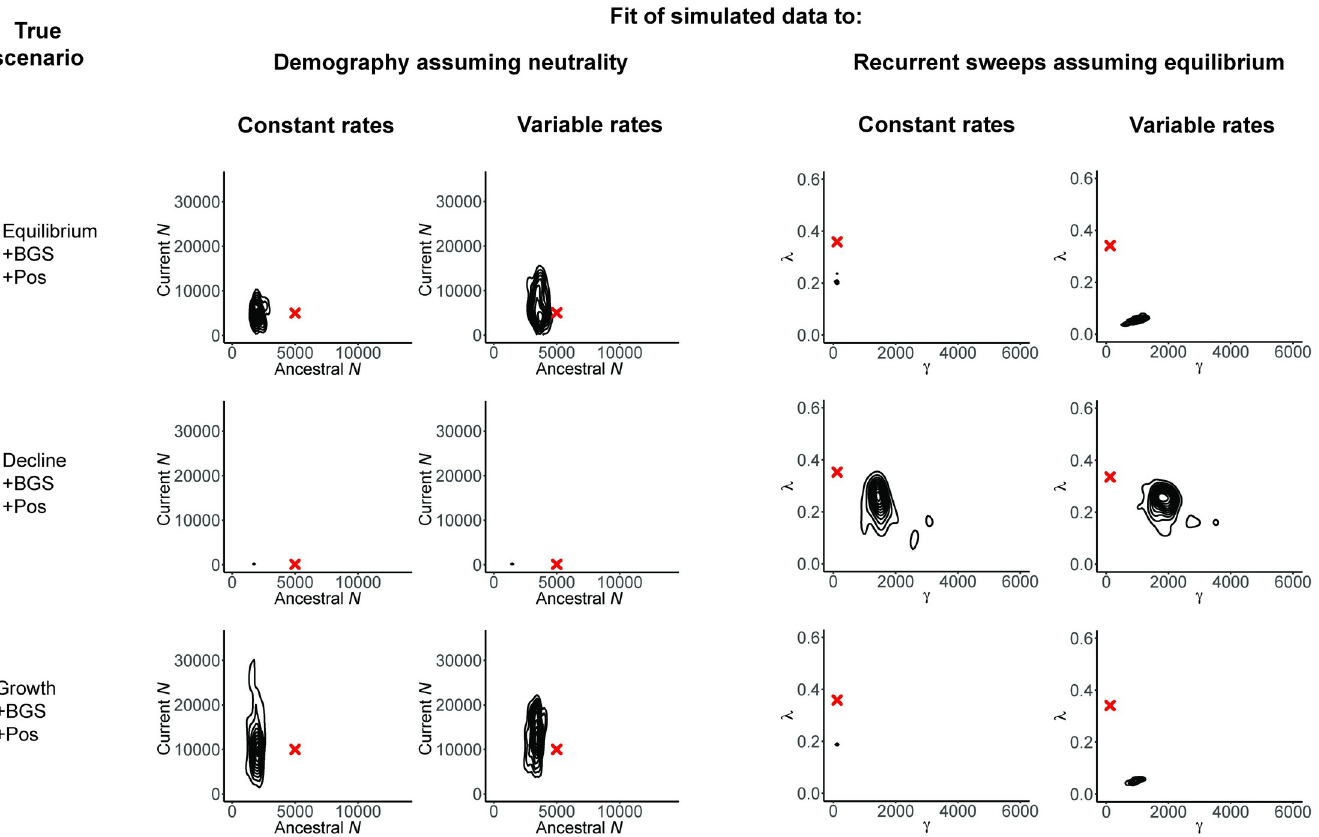
Fig 4. The effects of not correcting for mutation and recombination rate heterogeneity. Three scenarios are here considered: equilibrium population size with background selection and recurrent selective sweeps (“Eqm +BGS + Pos”), declining population size together with background selection and recurrent selective sweeps (“Decline + BGS + Pos”), and growing population size together with background selection and recurrent selective sweeps (“Growth + BGS + Pos”). Inference is again made under an incorrect demographic model assuming neutrality, as well as an incorrect recurrent selective sweep model assuming equilibrium population size. However, within each category, inference is performed under 2 settings: mutation and recombination rates are constant and known and mutation and recombination rates are variable across the region but assumed to be constant (see Methodology). Red crosses indicate the true values, and all exonic (i.e., directly selected) sites were masked prior to analysis. As shown, neglecting mutation and recombination rate heterogeneity across the genomic region in question can have an important impact on inference, particularly with regard to selection models. The scripts underlying this figure may be found at https://github.com/paruljohri/Perspective_Statistical_